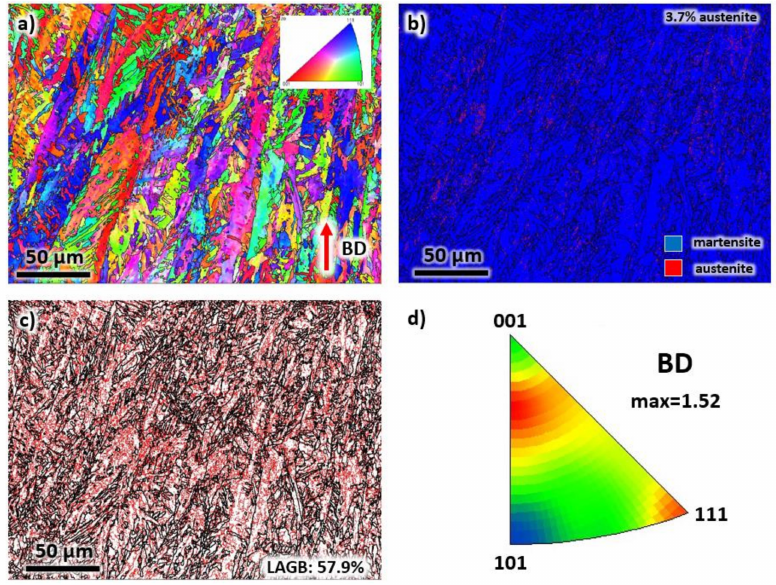
Figure 4. The ( a ) EBSD map, ( b ) phase map, ( c ) grain boundary map, and ( d ) IPF representation of each grain of the as-printed sample taken from the building